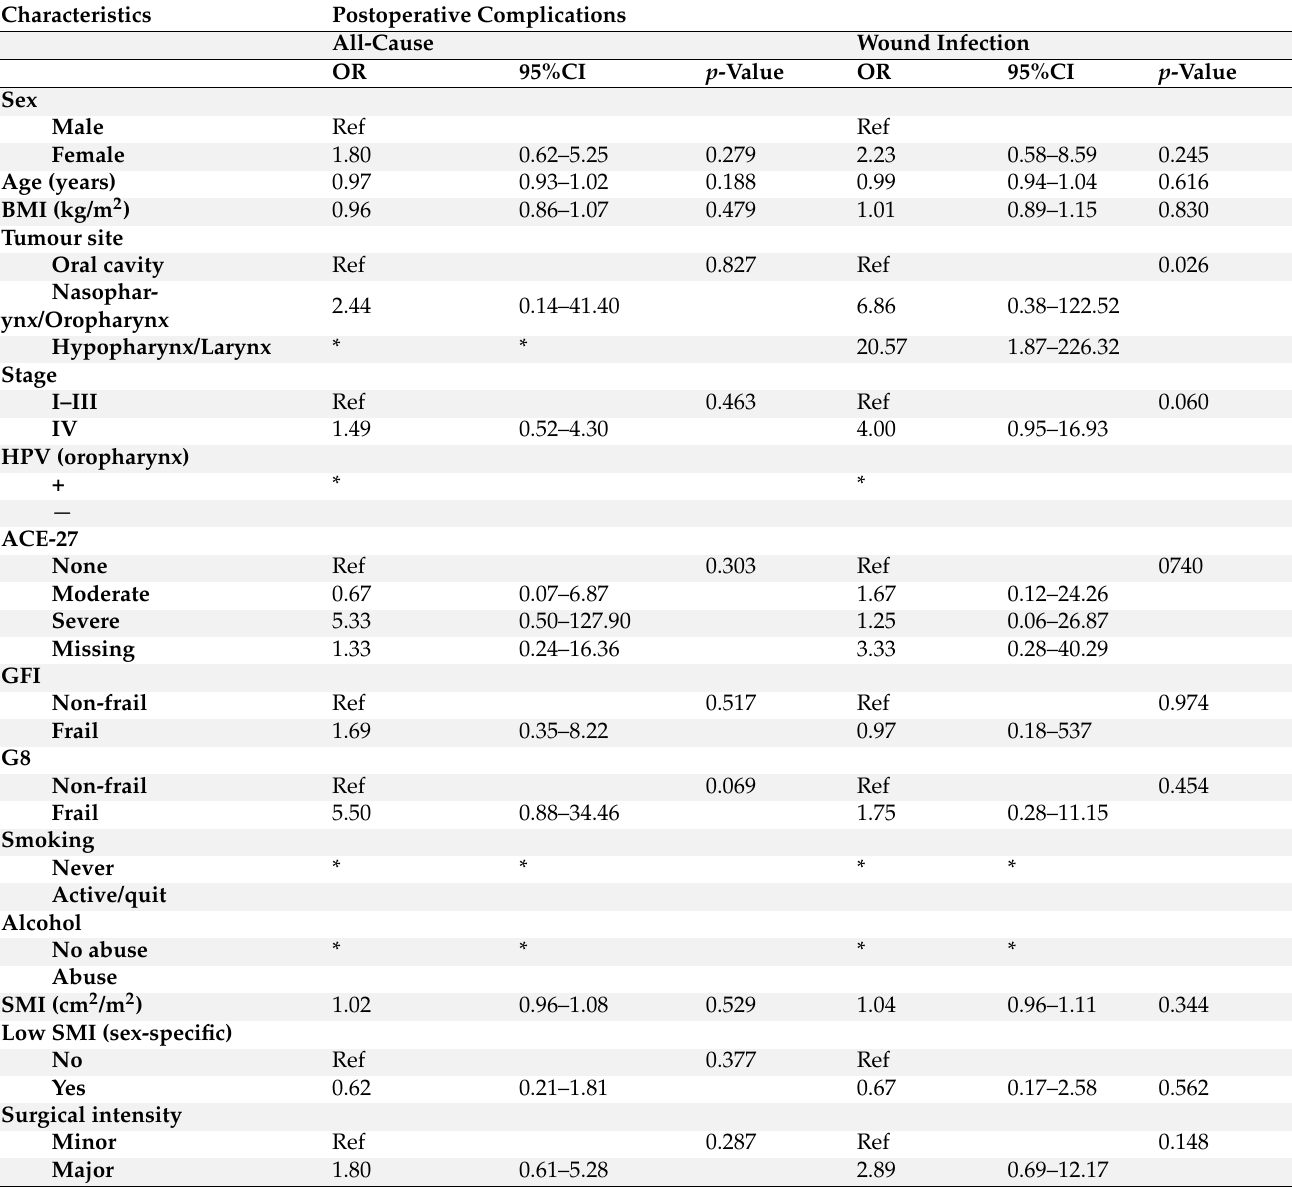
Table 5. Univariable logistic regression for individual predictors of all-cause postoperative